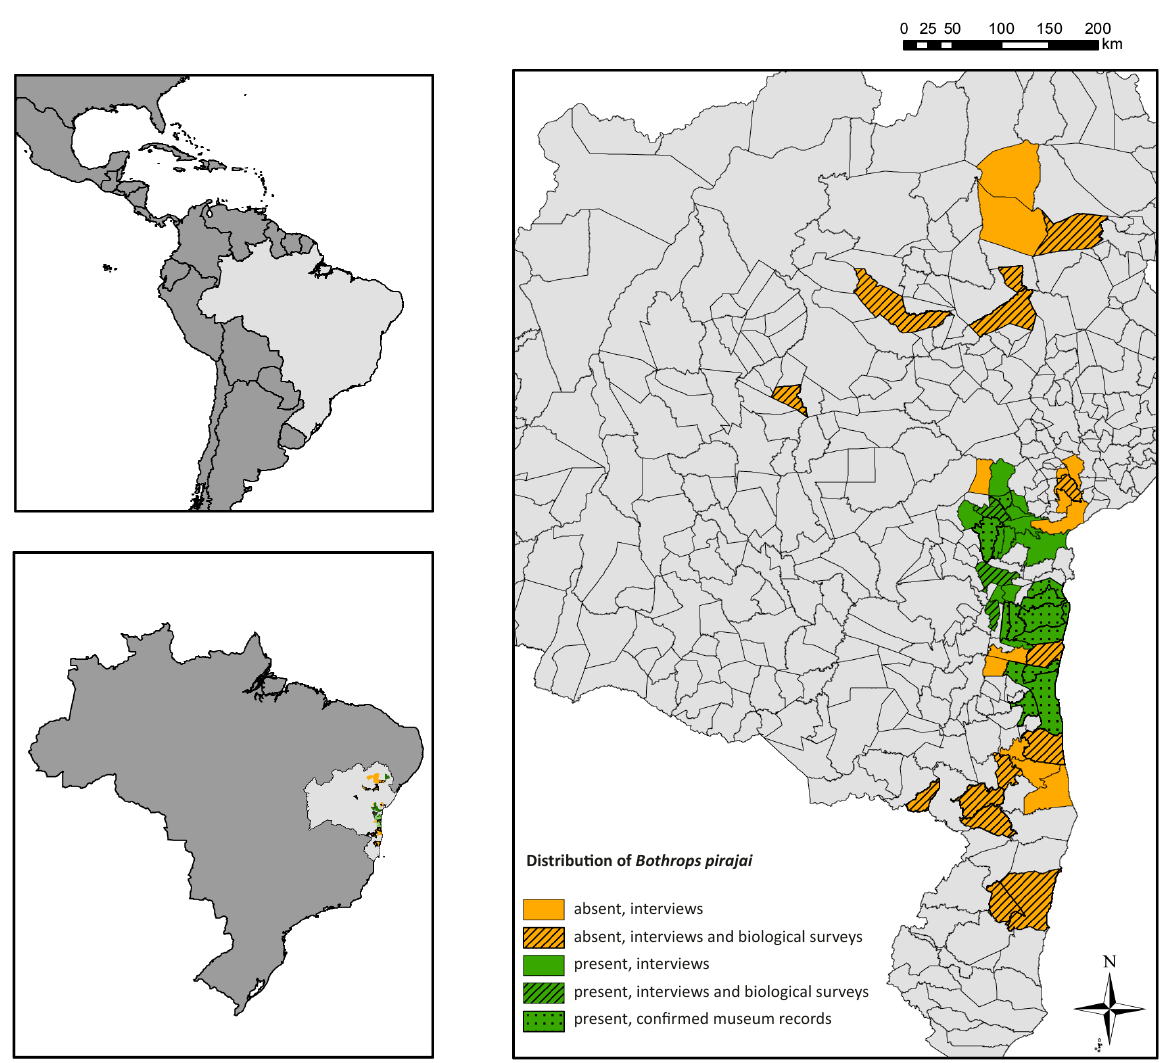
Figure 1. The presence/absence of Bothrops pirajai by municipalities, as determined by biological and social